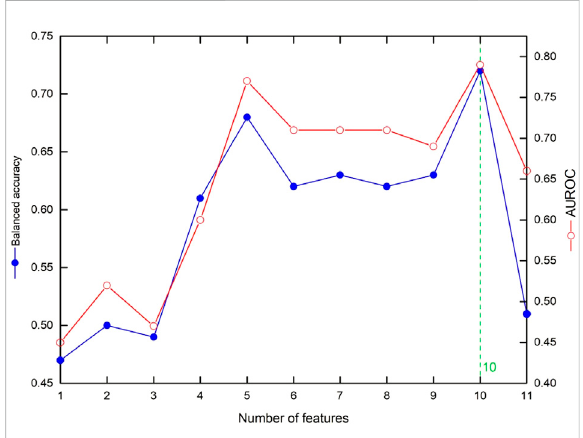
FIGURE 3 The in fl uence of the ranked features on cross-validation accuracy metrics: the values of balanced accuracy and AUROC according to the number of top